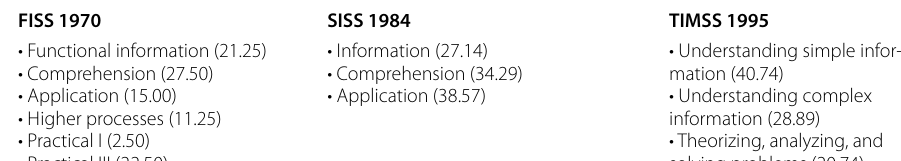
Table 10 Cognitive domains of the science achievement tests